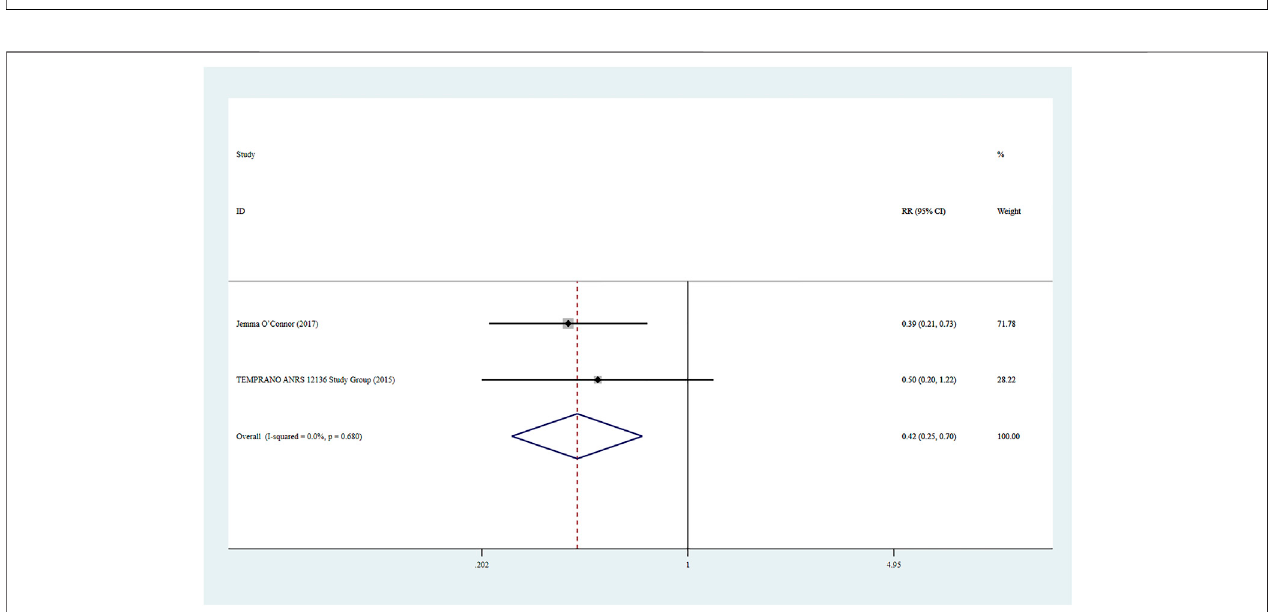
FIGURE 7 | Forest plot for Meta-analysis of infected